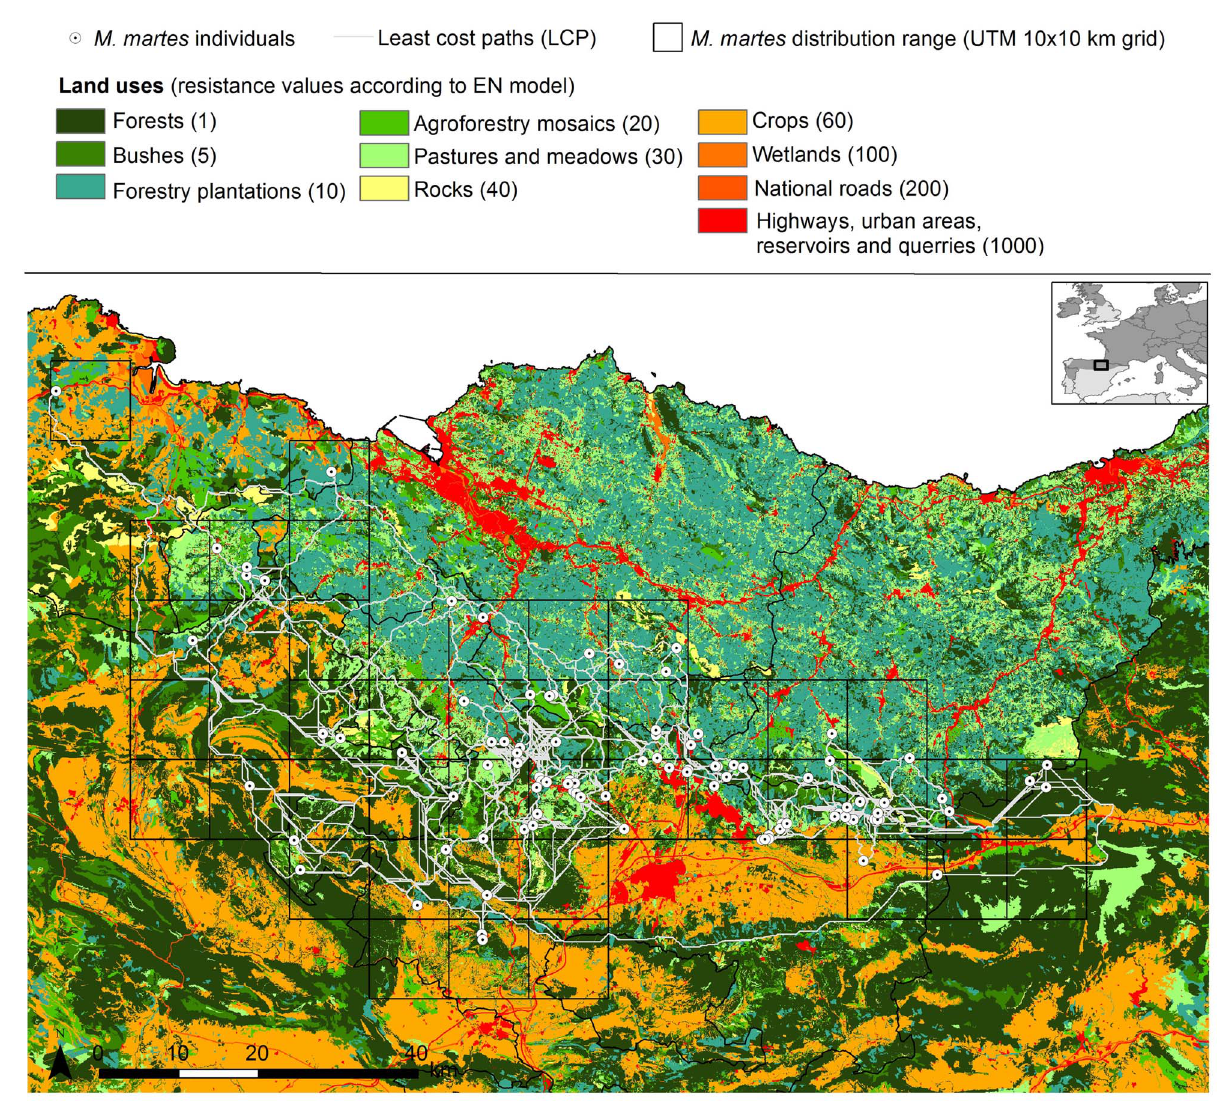
Figure 1. Ecological network resistance map (EN) and LCP analysis between European pine marten individuals in the study area. Least cost paths (LCP) obtained between the 101 pine marten individuals in accordance with the EN resistance map, analogous to that used in the design of the corridors in the ecological network of the Basque Country (North Spain) [41]. Resistance values for each land use are indicated in brackets.